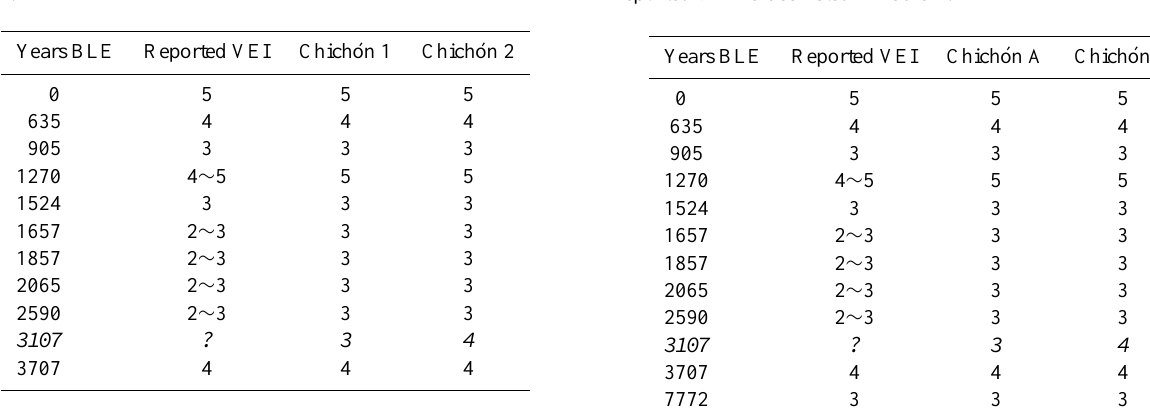
Table 2. Two possible models of VEI magnitude distributions for the VEI ≥ 3eruptions of El Chich´on volcano in 3707years BLE. The second column reproduces the published VEI values listed in Ta- ble 1.